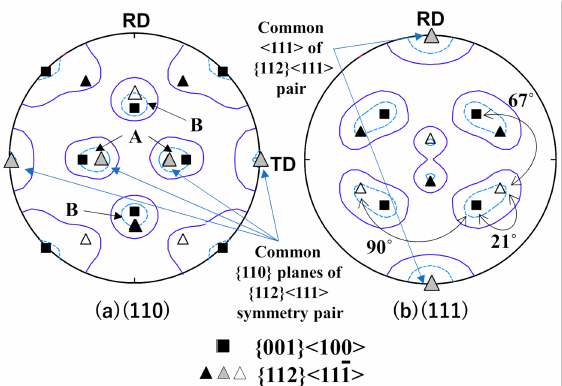
Figure 11. Orientations of ( a ) (110) and ( b ) (111) poles of {001}<100> and {112}<111> components in β structure. Two components in a {112}<111> sample–symmetry pair are distinguished by black and white triangles. Gray triangles represent common poles of the symmetry